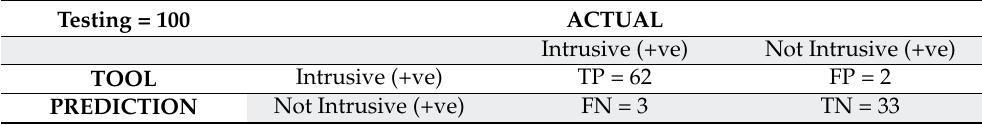
Table 2. Results of Label and Unlabeled Semi-Supervised